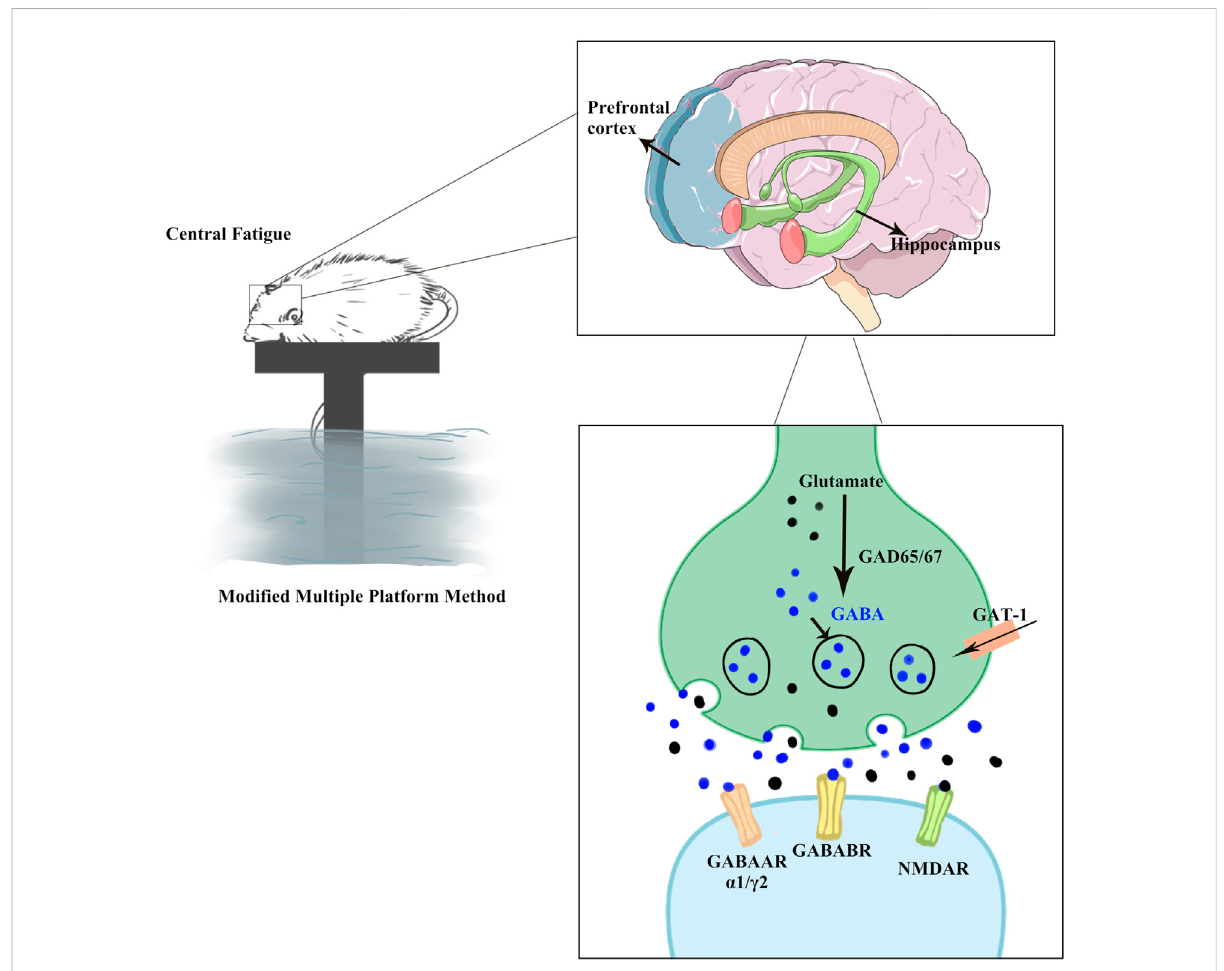
FIGURE 10 GABA/Glu signaling pathway prediction. CF over-activated the GABAergic system and inhibited theGlu-ergic system, resulting in hippocampal and prefrontal cortex damage, as well as cognitive and emotional disorders in rats. KPLD could be used to regulate the changes in Glu and GABA levelsaswellasimprovethecognitive,emotional,andphysicaldisordersofratswithCF.GABAAR α 1andGABAAR γ 2,assubunitsofGABAAR,aremore widely distributed in the hippocampus and cortex. GABABR is a heterodimer comprising of GABABR1 and GABABR2 subunits. GABA is formed through Glu conversion, which is mediated by the rate-limiting enzyme GAD. GAD67, an important isozyme, is involved in the synthesis of GABA. GAT-1 is a GABA transporter that regulates GABA reuptake to reduce GABA levels. NMDAR2B, as receptor of Glu, is of signi fi cant importance in dynamic processes such as learning and